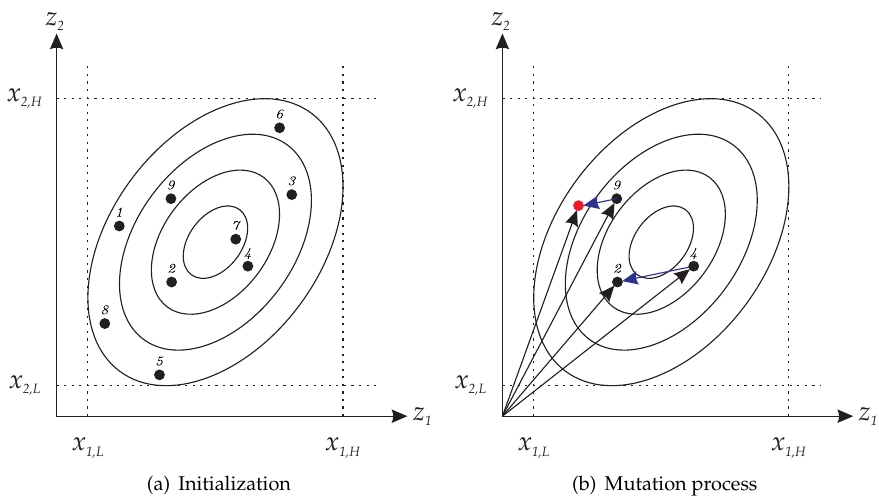
Figure 8. Representation of the mutation process and first generation of the solution for the DEA. Figure adapted from